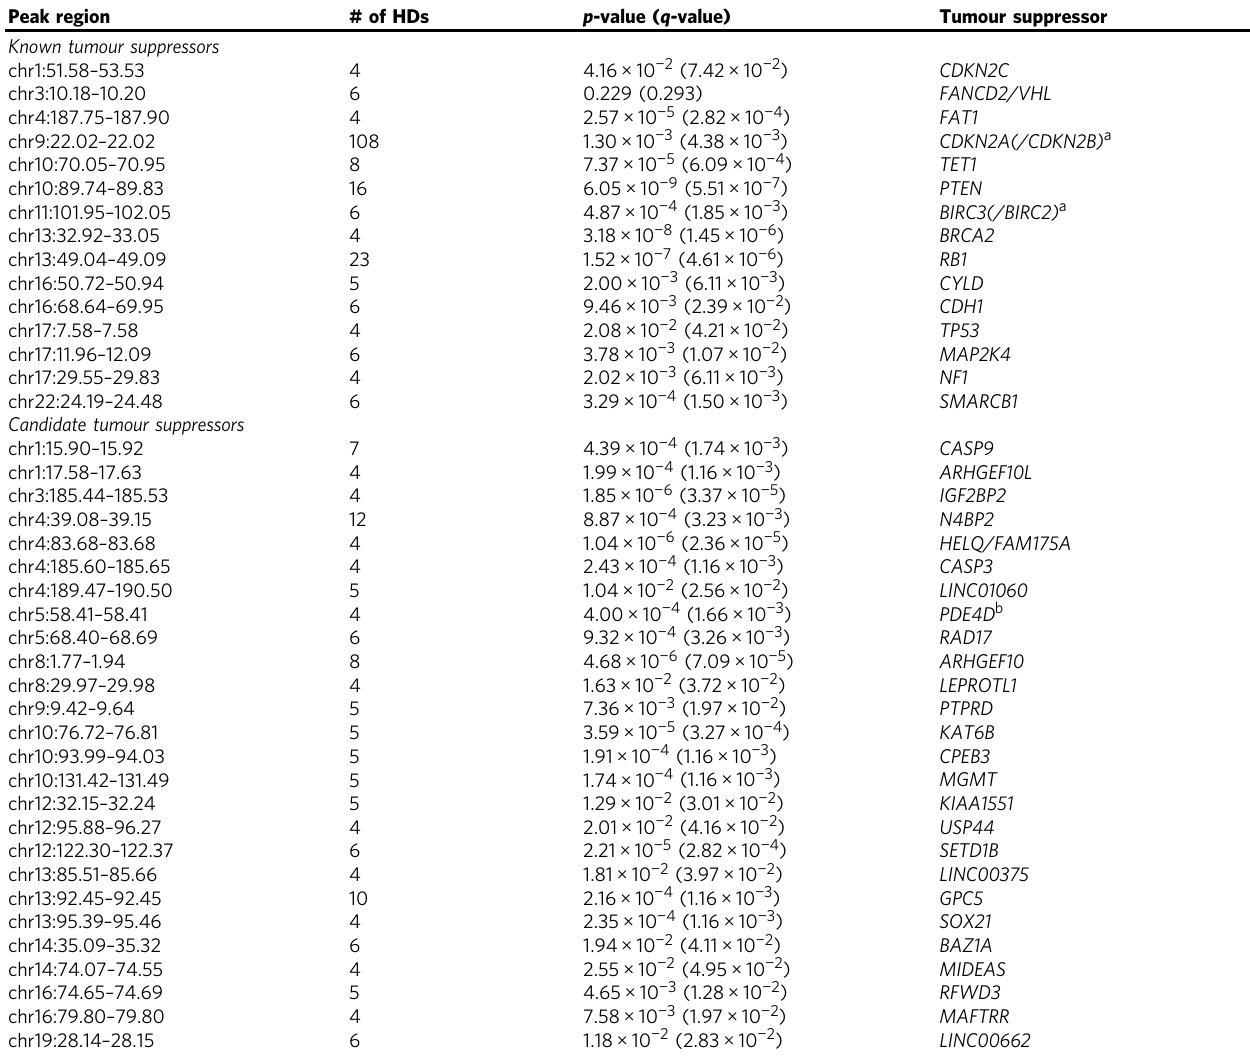
Note : Each region ’ s genomic position is shown, the number of homozygous deletions (HDs), the combined p -value (and multiple testing-corrected q -value) indicating the probability that the enrichment in homozygous deletions is due to increased genomic instability (rather than due to positive selection), and the established or candidate tumour suppressor gene identi fi ed a CDKN2B and BIRC2 are candidate tumour suppressor genes with a high level of evidence. They are always lost together with CDKN2A and BIRC3 , respectively, and are likely to contribute to positive selection of the homozygous deletions b PDE4D shows intragenic homozygous deletions, suggesting that these deletions may be gain-of-function rather than loss-of-function